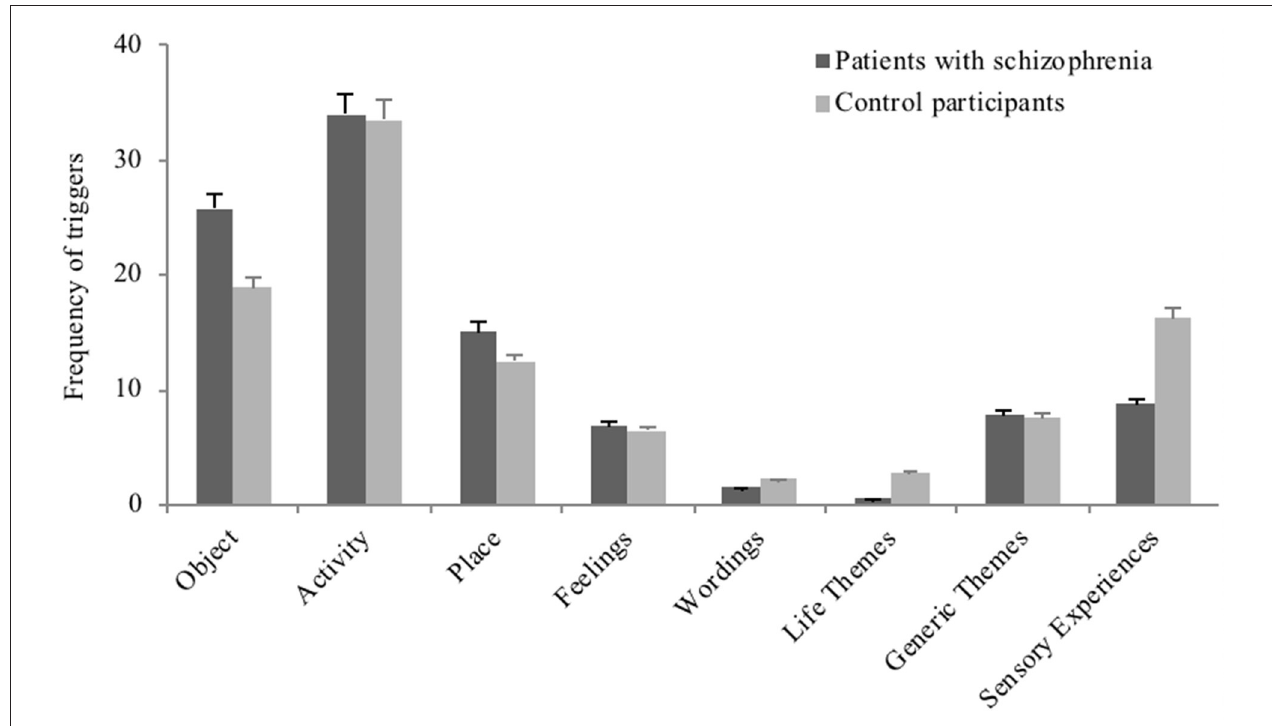
FIGURE 3 | The plot shows the proportion of involuntary autobiographical memories triggered by each cue category in patients with schizophrenia and in control participants, in Study 2. Error bars represent standard errors.